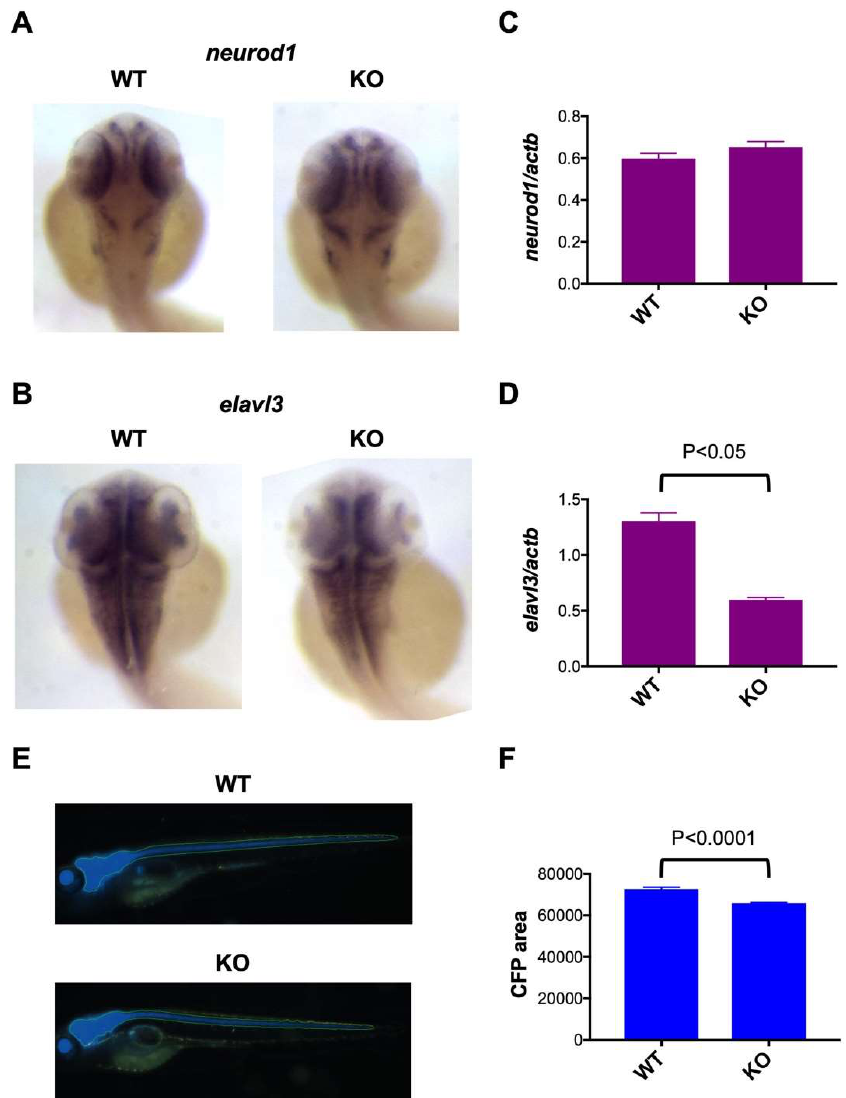
Figure 4. Impaired neuronal marker expression in c3orf70-KO zebrafish. ( A – D ) Whole-mount in situ hybridization ( A and B ) and qPCR ( C and D ) of neurod1 ( A and C ) and elavl3 ( B and D ) expression in c3orf70 WT and KO zebrafish at 2 dpf. Data are presented as the mean ± SEM of n = 4 for both WT and KO. ( E and F ) Representative images ( E ) and quantification of fluorescence ( F ) in Tg (eno2: Cerulean) c3orf70-WT or KO zebrafish at 5 dpf. Data are presented as the mean ± SEM of n = 60 and 62 for WT and KO groups, respectively.